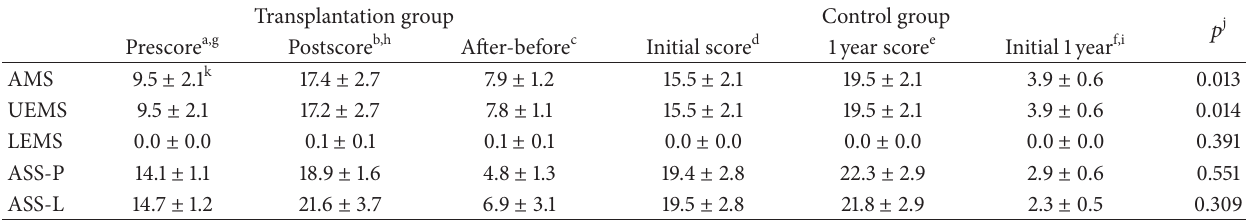
Table 5: Summary of AMS and ASS changes in patients with complete cervical